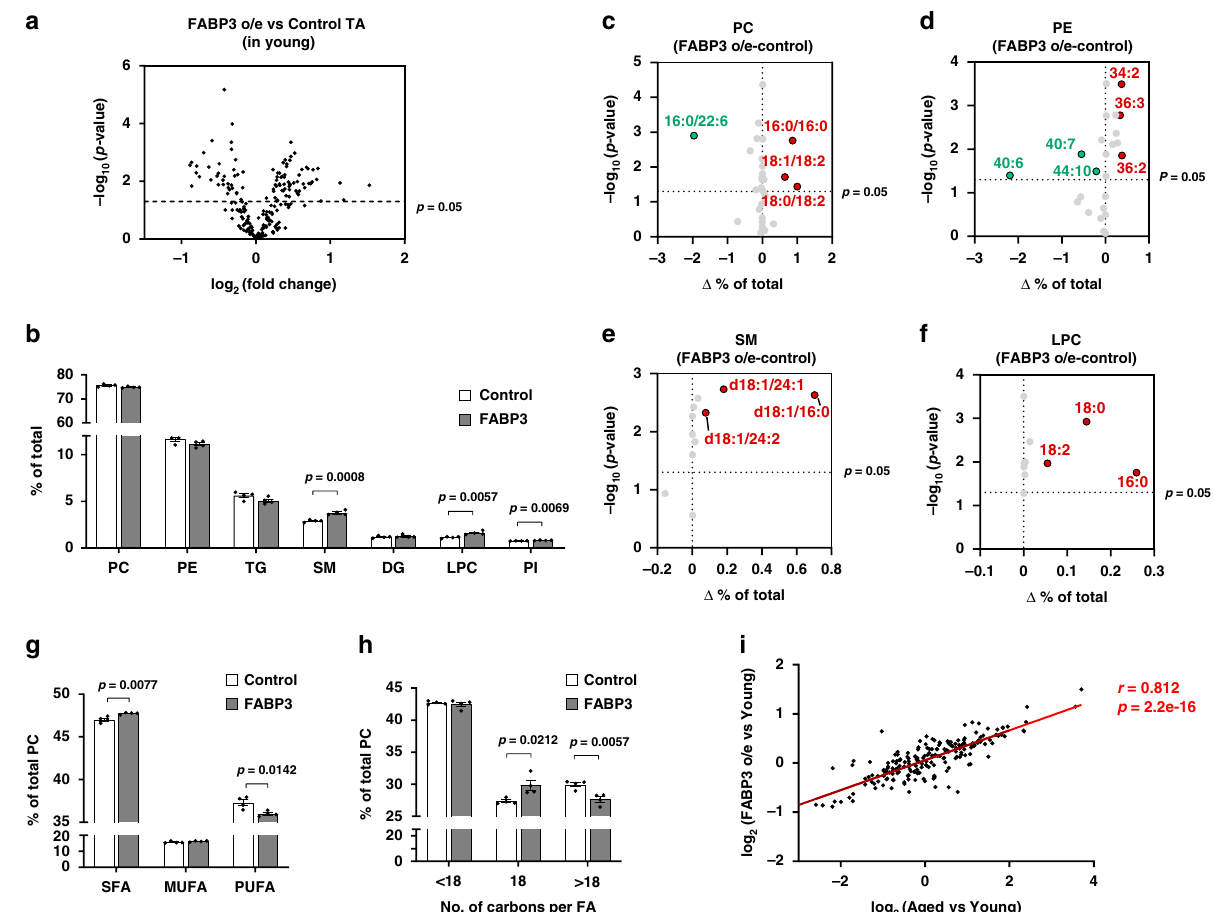
Fig. 2 FABP3-overexpressing young muscle exhibits lipid composition similar to aged muscle. a Volcano plot of lipid species altered in FABP3- overexpressing muscle vs. control muscle. Lipid species were measured by LC-MS. The x -axis indicates the logarithmic (base 2) fold abundance changes of all identi fi ed lipid species and the y -axis indicates negative logarithmic (base 10) t -test p -value. The horizontal dotted line re fl ects the fi ltering criterion ( p -value = 0.05). ( n = 4 mice per group). b Proportion of major lipid classes in FABP3-overexpressing and control muscles. c – f Volcano plot of PC ( c ), PE ( d ), SM ( e ), and LPC ( f ) species altered in FABP3-overexpressing vs. control muscles. The x -axis indicates the percentage changes (FABP3 o/e-control) in lipid species and the y -axis indicates negative logarithmic (base 10) t -test p -values. The horizontal dotted line re fl ects the fi ltering criterion ( p -value = 0.05). Red and green indicate highly increased and decreased lipid species, respectively. g Proportion of SFA, MUFA, or PUFA PC acyl chains in FABP3- overexpressing and control muscles. h Proportion of <C18, C18, or >C18 PC acyl chains in FABP3-overexpressing and control muscles. Data are presented as means ± S.E.M. Two-tailed unpaired Student ’ s t -test was used. i Correlation analys i s of the total identi fi ed lipid species in the indicated comparative condition. The x -axis indicates logarithmic (base 2) fold concentration changes of all identi fi ed lipid species in aged vs. young muscle, and the y -axis indicates logarithmic (base 2) fold changes in FABP3-overexpressing muscle vs. young muscle. Data in i were analyzed using Spearman ’ s correlation; correlation coef fi cient ( r ) and p -value ( p ) are in red. Source data are provided as a Source Data fi